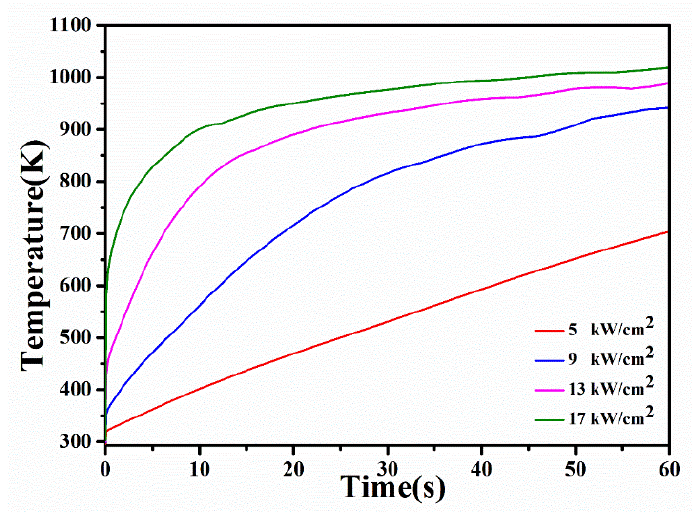
Figure 2. Simulation results of wafer center temperature under power density of 5000, 9000, 13,000 and 17,000 W/cm 2 .